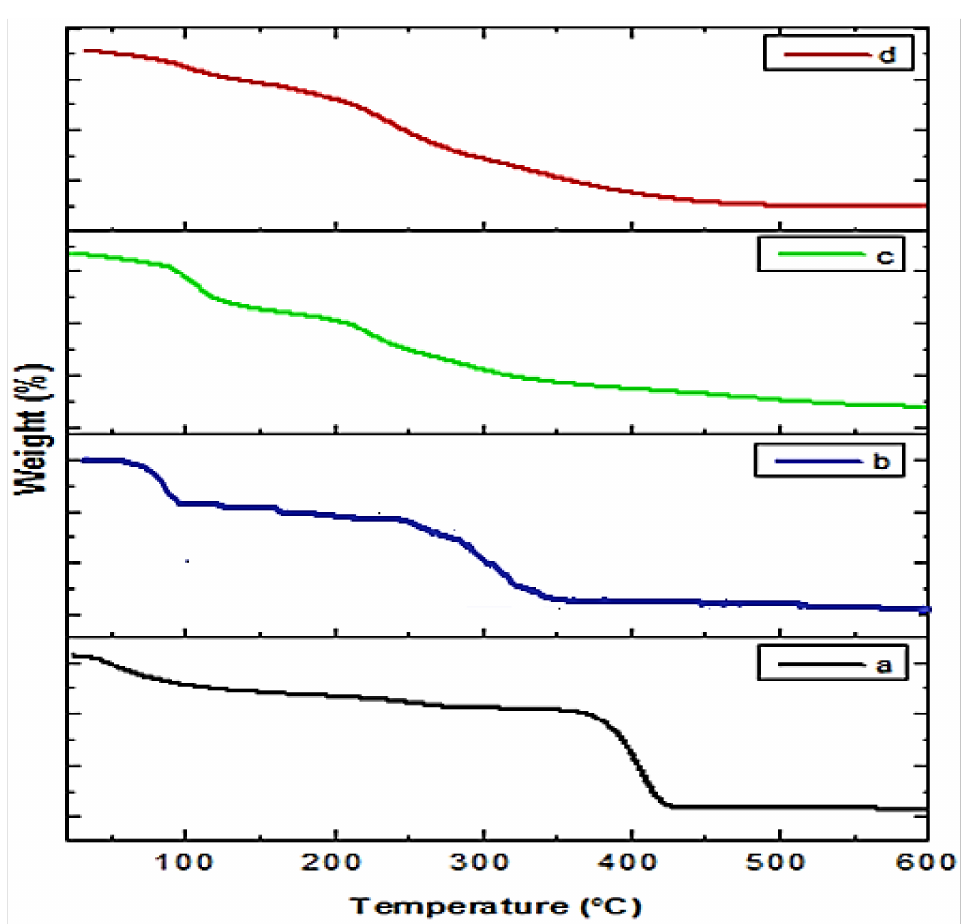
Figure 7. TG thermograms of Ext+Ch NPs ( a ), Ext+PEG NPs ( b ), crude extract ( c ), and Ext+LBG NPs ( d